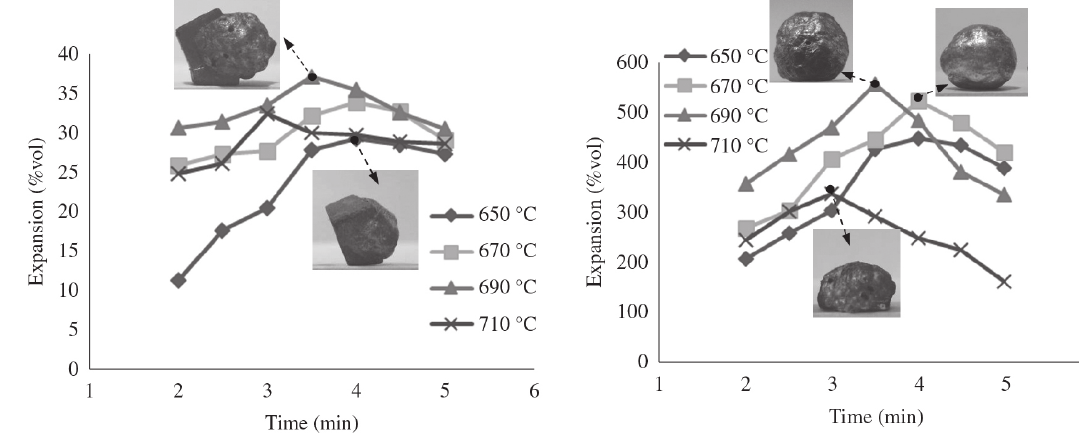
Figure 3. Expansion rates of 10% deformed samples at various foaming temperatures.